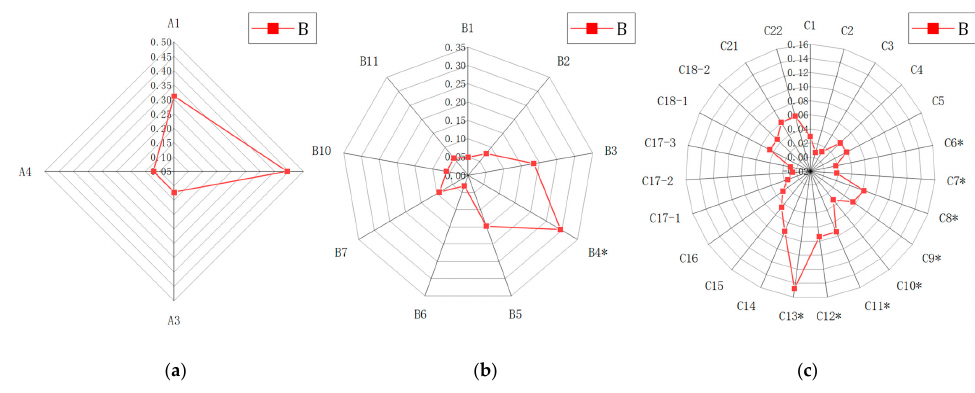
Figure 4. Weight distribution of the second ( a ), third ( b ), and fourth ( c ) indices.